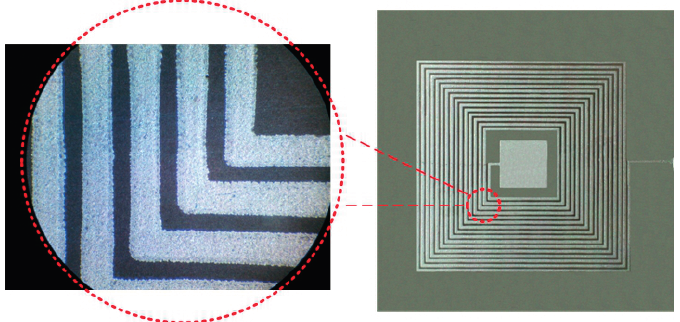
Figure 5. Prototype of the resonator.